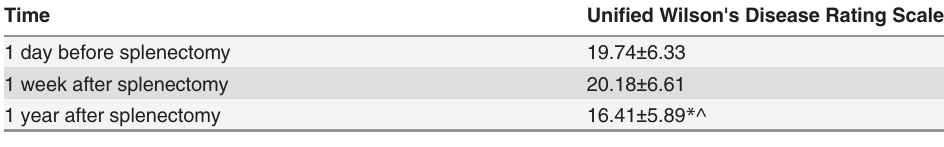
Table 5. Neurological symptom scoring before and after splenectomy (mean ±